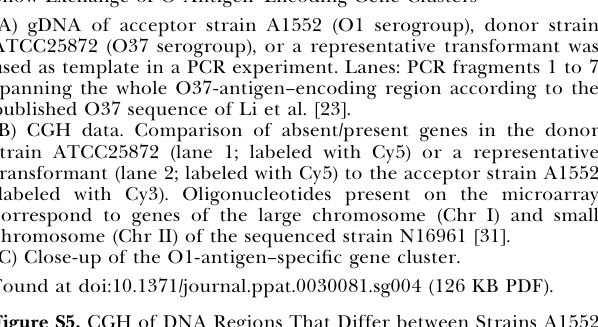
Table S1. Oligonucleotides Used in This Study Table S2. List of Microarrays and Corresponding GEO Accession